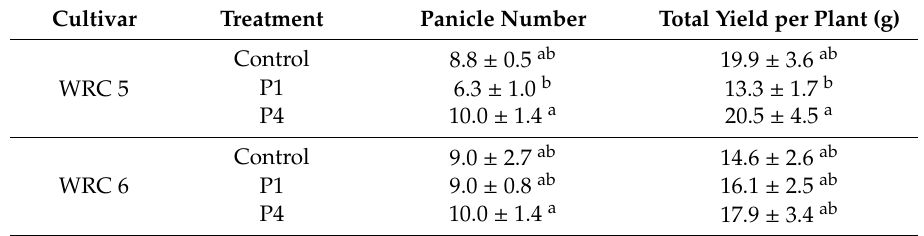
Table 2. Panicle number and total yield per plant of WRC 5 and WRC 6. Data are shown as the mean ± SD of four replicates. Di ff erent letters indicate statistical di ff erences (Tukey’s HSD test, p < 0.05). ± SD of four replicates. Different letters indicate statistical differences (Tukey’s HSD test, p < 0.05).